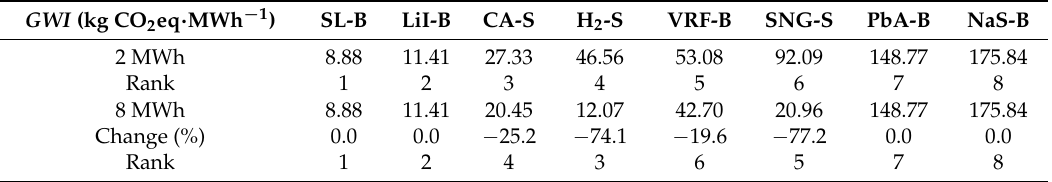
Table A4. Ranking of electrical energy storage technologies for GWI with 2 and 8 MWh storage capacity.